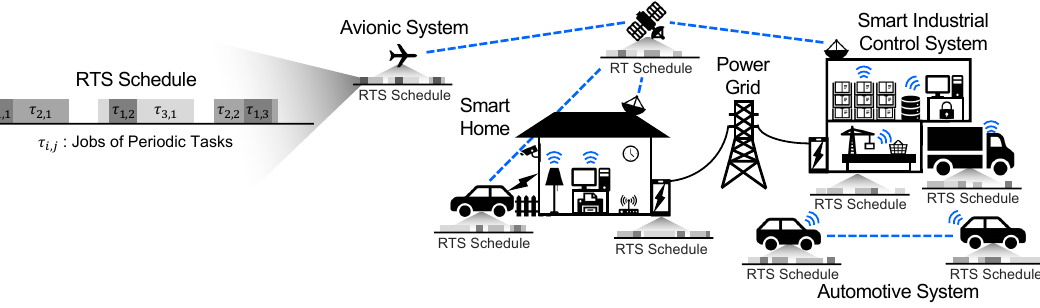
Figure 1. An overview of RT-IoT around everyday living. Dotted lines and radiate symbols indicate the wireless connectivity supported by the devices. Each RT-IoT device executes periodic real-time tasks (e.g., τ i , j denotes the j th activation of any task τ i ) required for safe operation of the physical system.